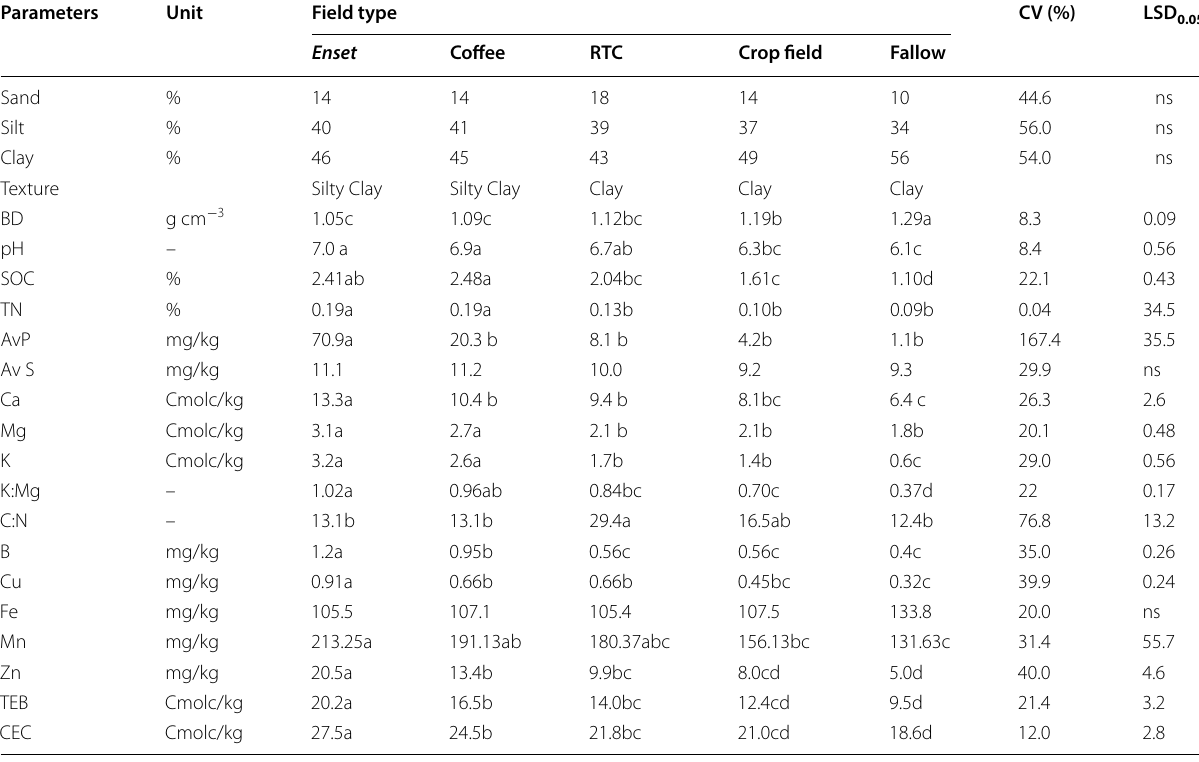
ns not significant, RTC root and tuber field